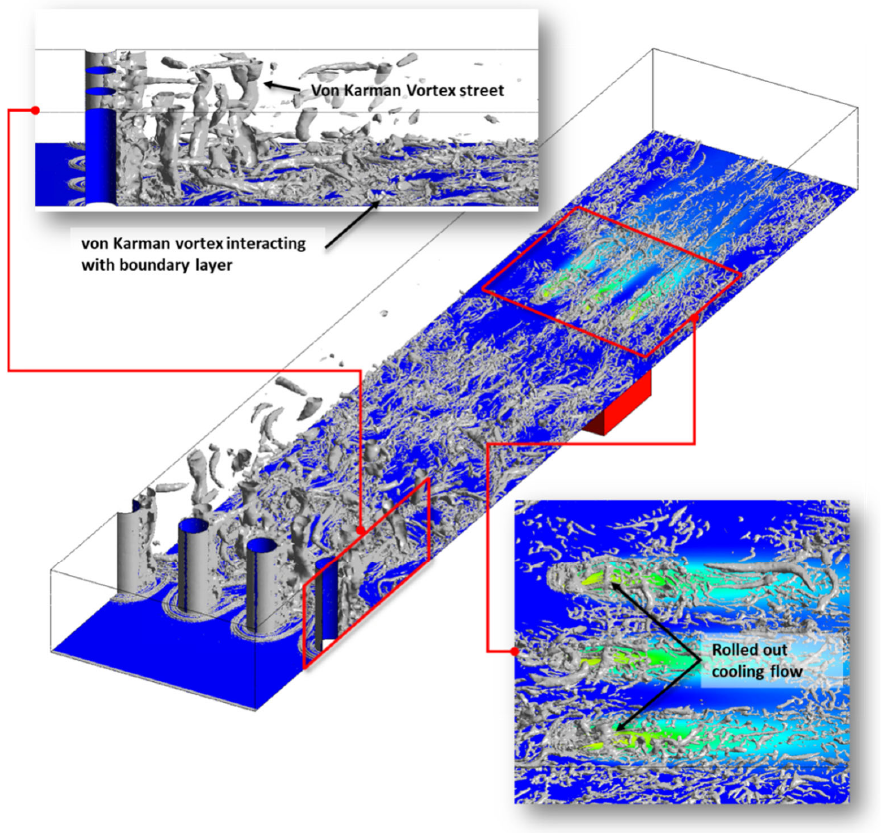
Figure 8. Instantaneous vortex structures when the blowing ratio is 2.0.